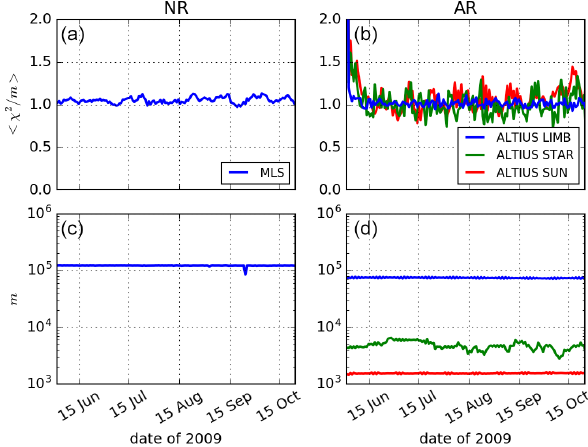
Figure 1. Time series of the χ 2 test (i.e. the daily mean χ 2 divided by the number of assimilated observations m , a, b ) and the number of assimilated observations (c, d) for the nature run (NR, a, c ) and the assimilation run (AR, b, d ).